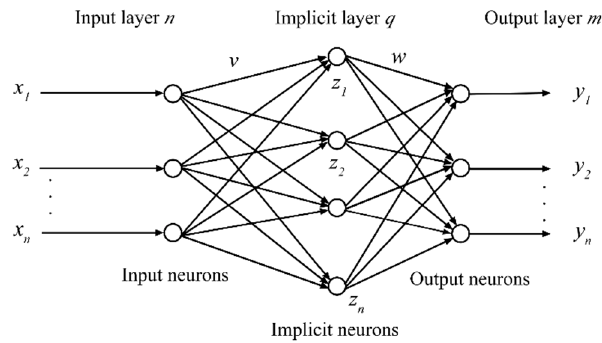
Figure 3. Structure of three-layer BP neural network.